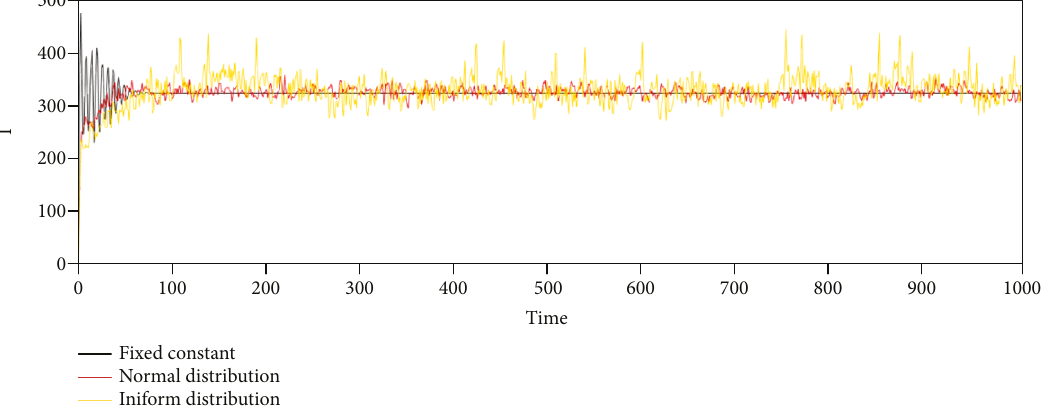
Figure 9: Change of initial inventory of warehouse allocation system in a stable state under three demand